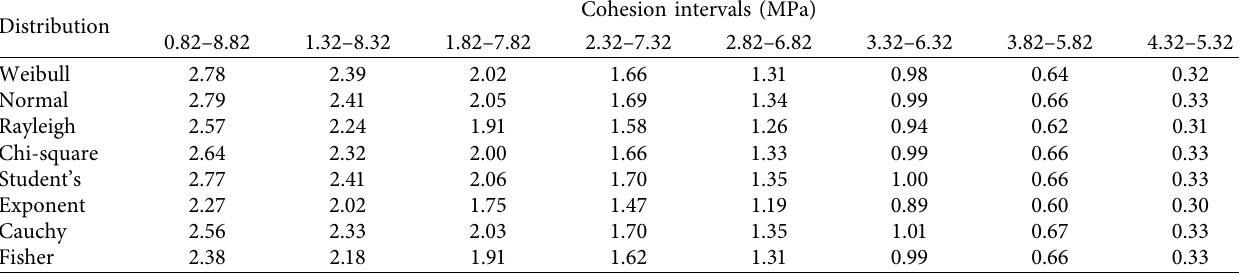
Cohesion intervals